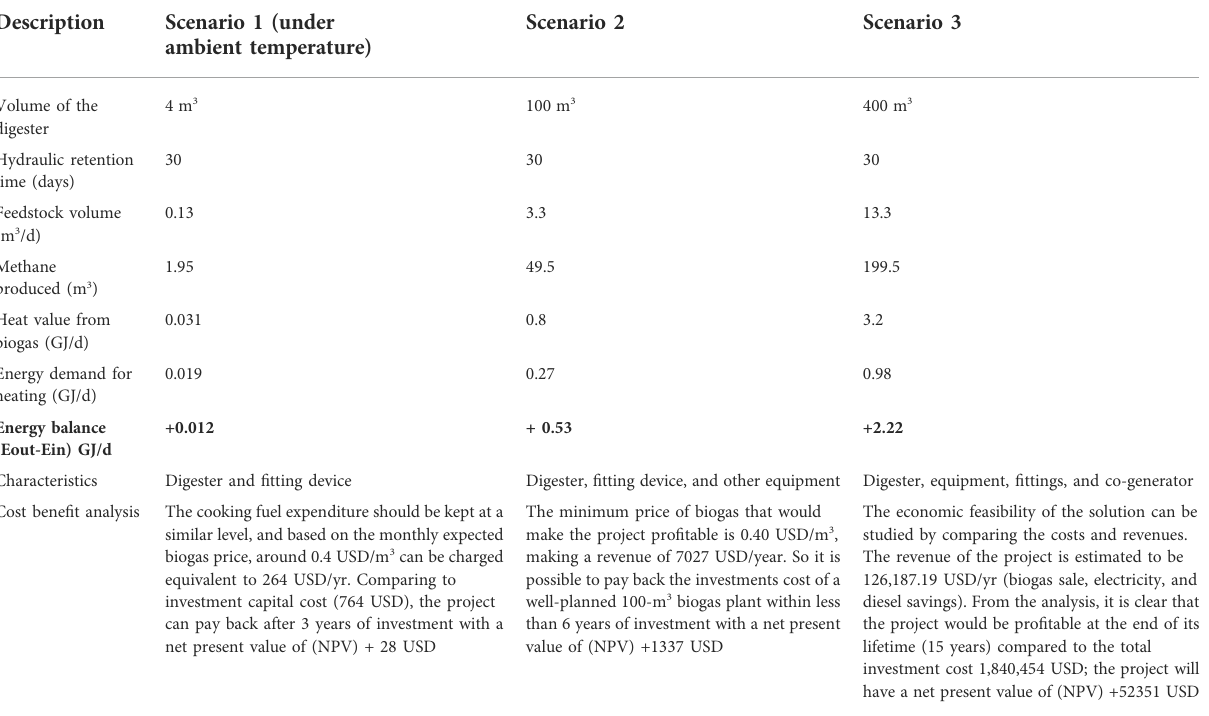
TABLE 5 Summary of three scenarios for FS anaerobic